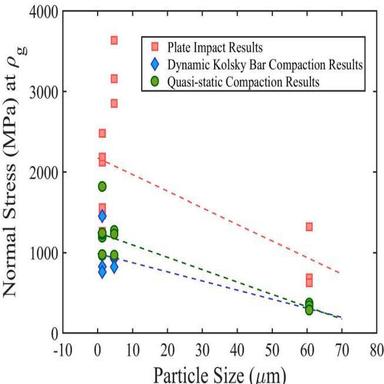
Comparing the normal stress of the three angular boron carbide powders at a specific density ρg of 1700 Kg/m3 under quasi-static loading, Kolsky bar and plate impact loading conditions. The data points around 1 μm are from the fine powder. The points at ~4 μm are for the intermediate, and coarse powder corresponds to the points around 60 μm.